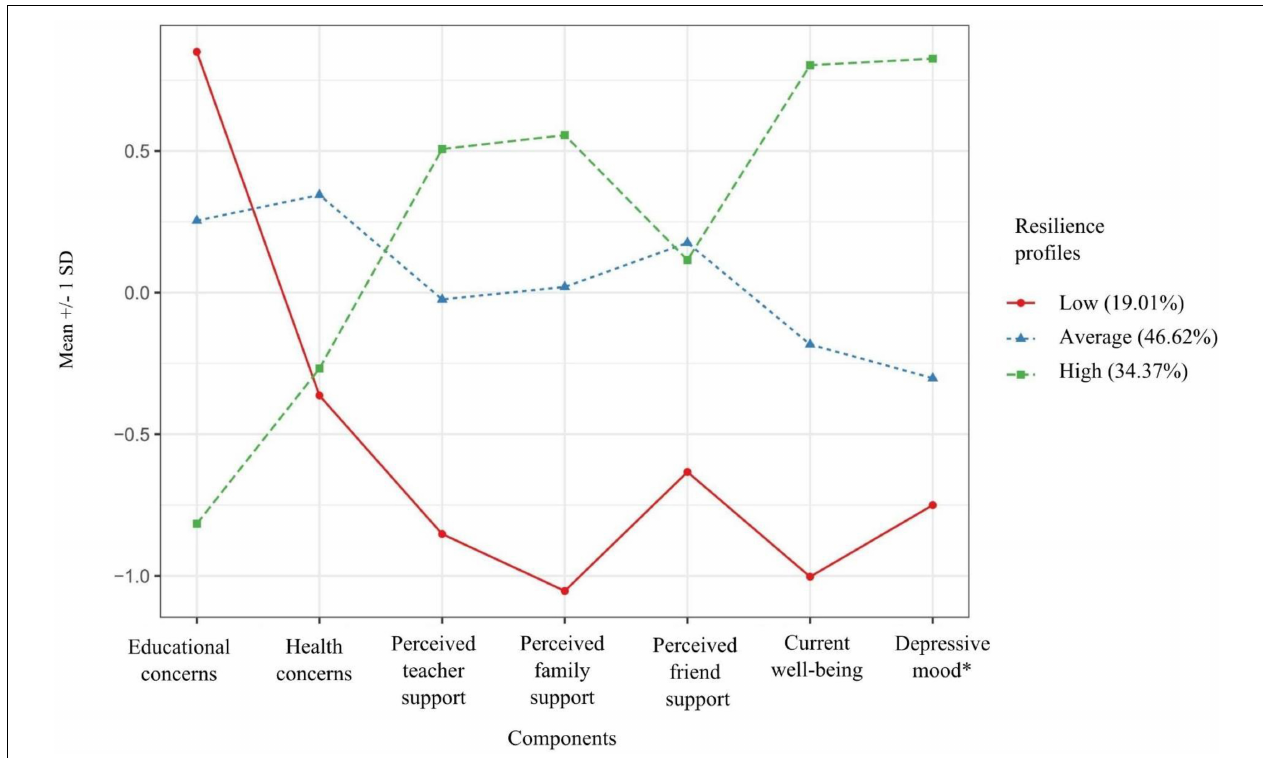
FIGURE 1 | Latent resilience profiles. Scales marked with an asterisk ∗ were recoded so that higher values of depressive mood reflect lower depressive levels. All components were mean-centered.